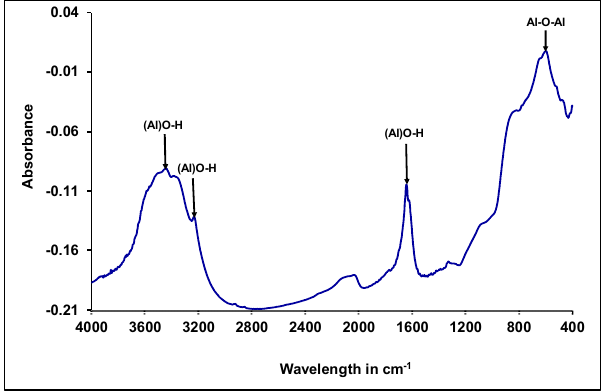
Figure 4. FT-IR spectrum of γ ANPs.